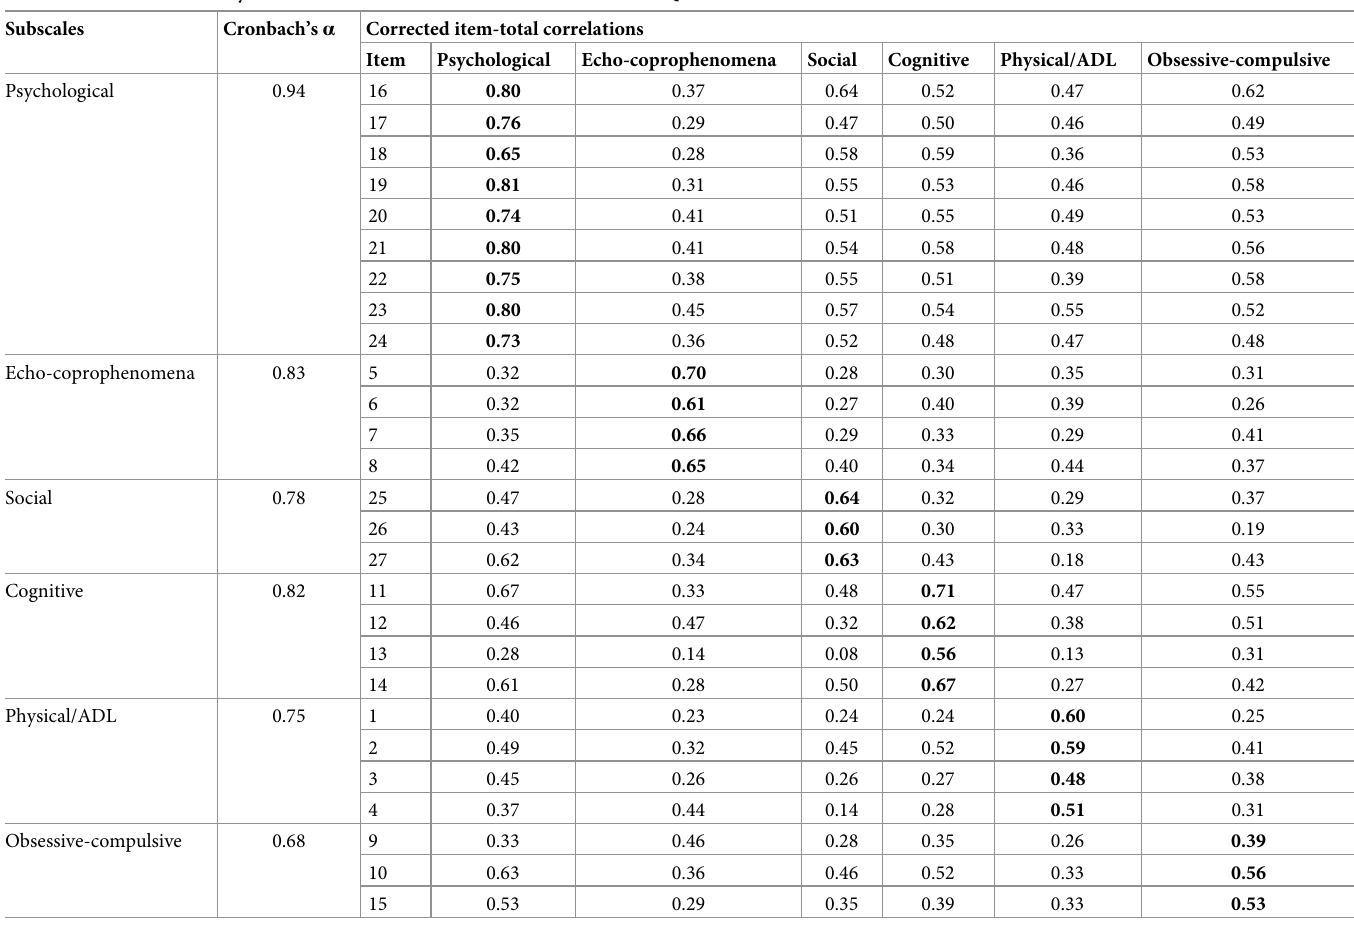
the ‘Echo-coprophenomena’ subscale (r = 0.44) and moderate correlations with the other sub- scales (from 0.56 to 0.67). The ‘Echo-coprophenomena’ subscale had small correlations with the other subscales (from 0.39 to 0.49). The ‘Social’ subscale had a moderate correlation with the ‘Psychological’ subscale (r = 0.67) and small correlations with the others (from 0.33 to Table 5. Internal consistency and corrected item-total correlations for the GTS-QOL-French subscales.